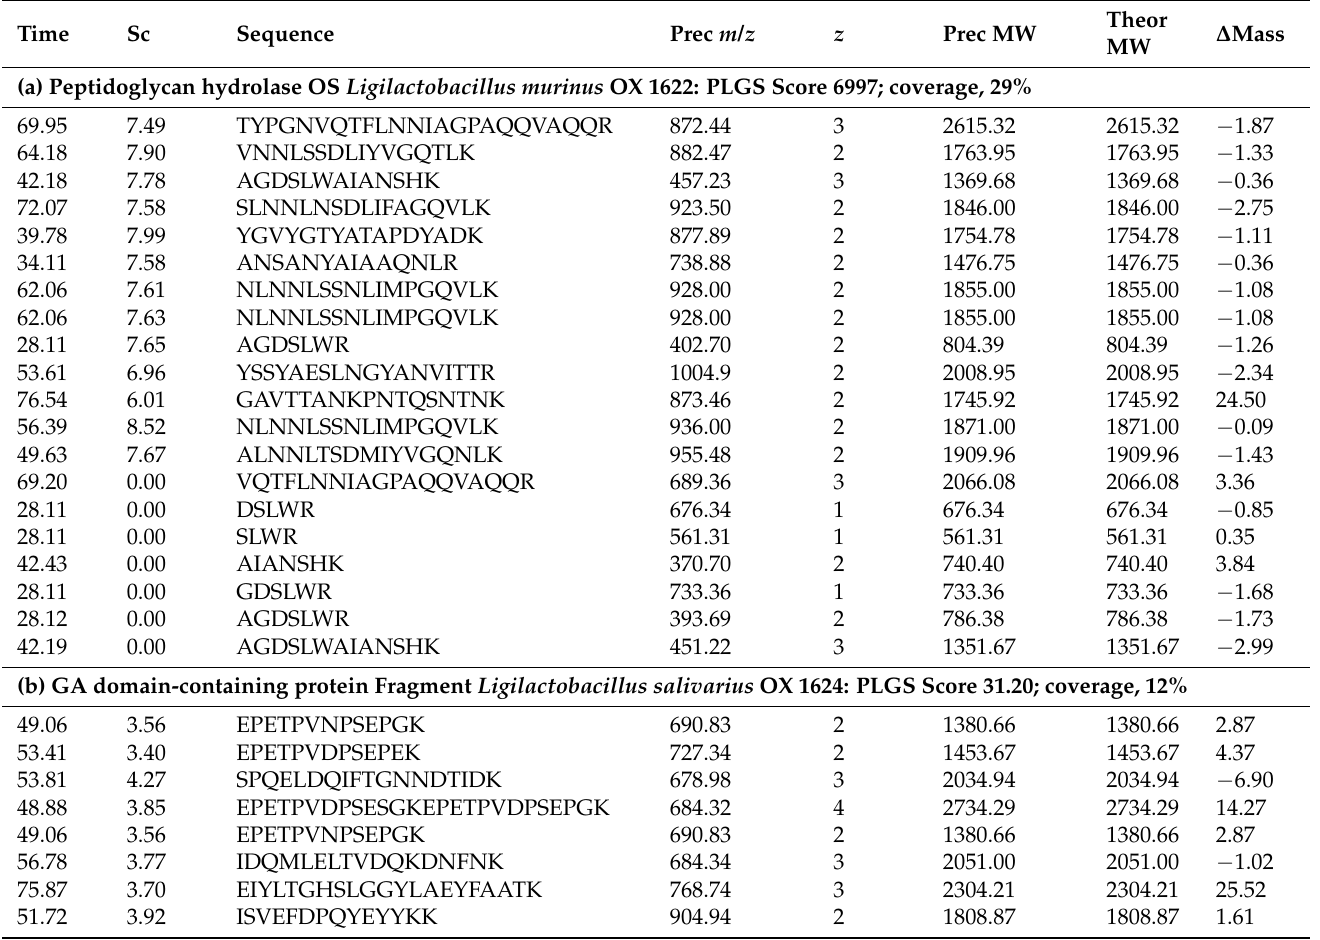
Table 5. Peptides obtained from the SDS-PAGE gel bands with lytic activity by UPLC-MS, ( a ) protein with an apparent molecular mass of 107 kDa and ( b ) 24